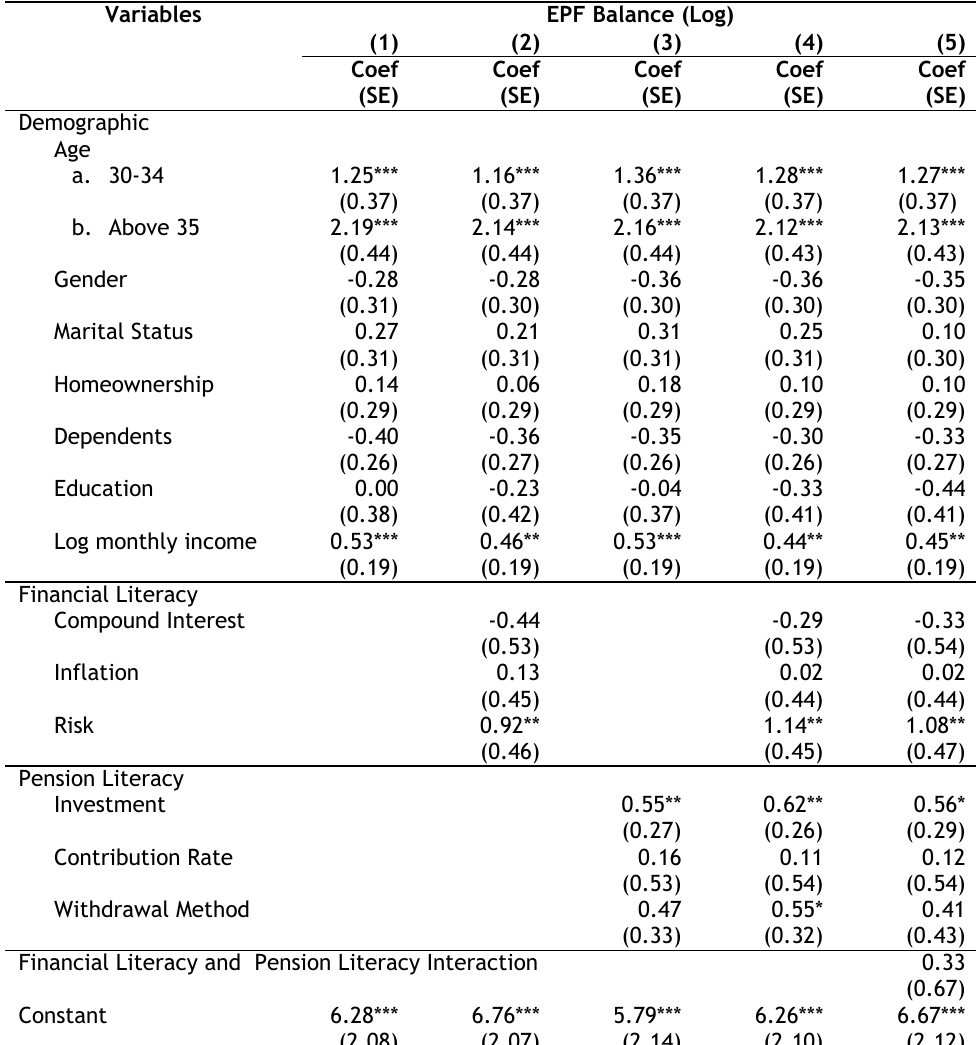
Table 5. Ordinary least squares regression results for EPF